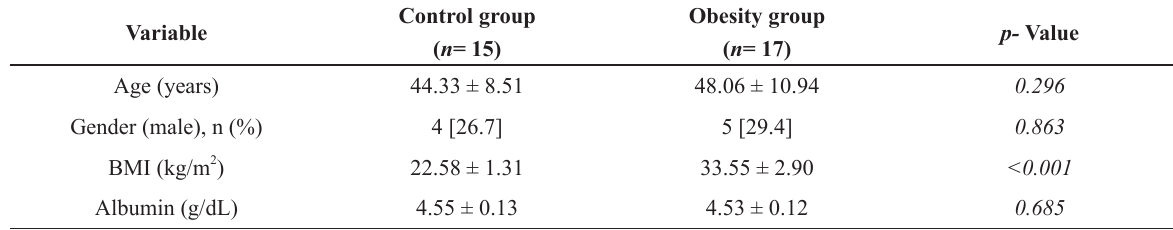
Demographic and laboratory parameters from the obese and control groups prior to the initiation of the exercise training.